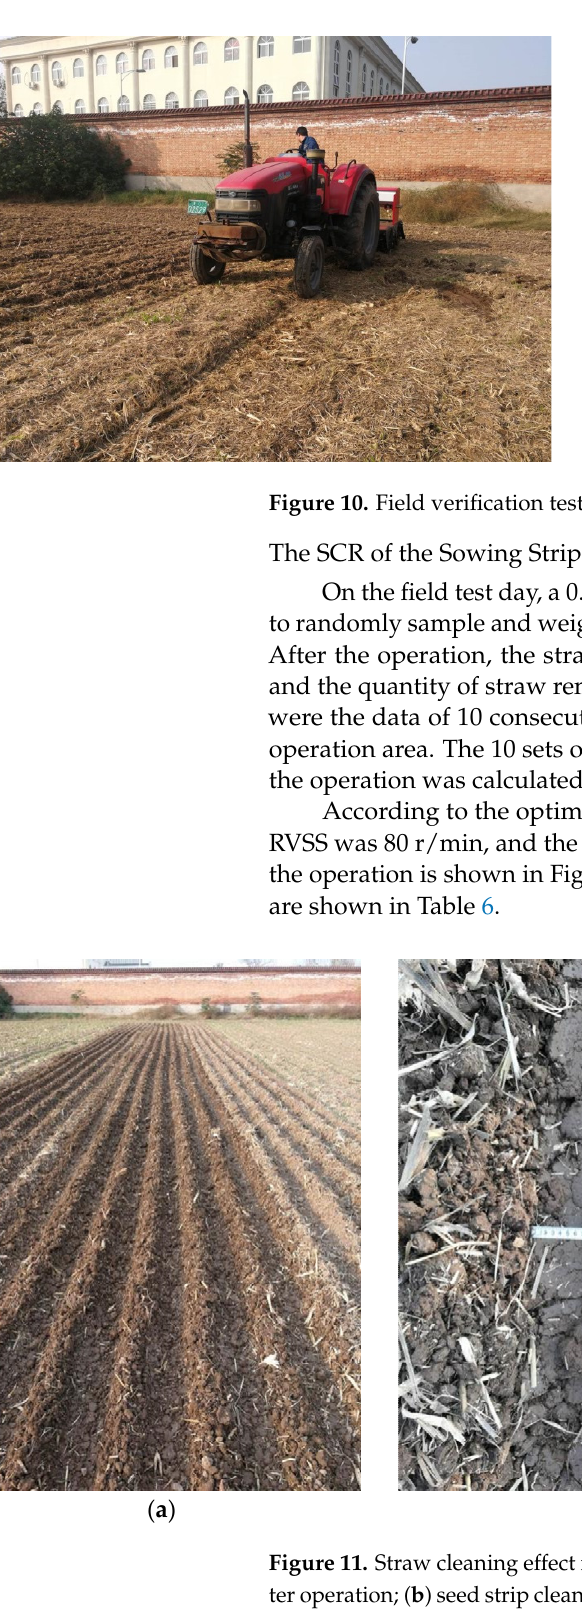
Figure 11. Straw cleaning effect in seed strip after the operation. ( a ) The overall effect with SDARD after operation; ( b ) seed strip cleaning effect with SDARD; ( c ) seed strip cleaning effect without SDARD.